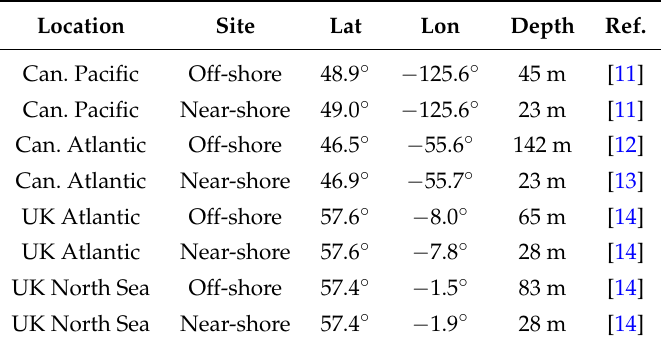
Table 2. Reanalysis wave data